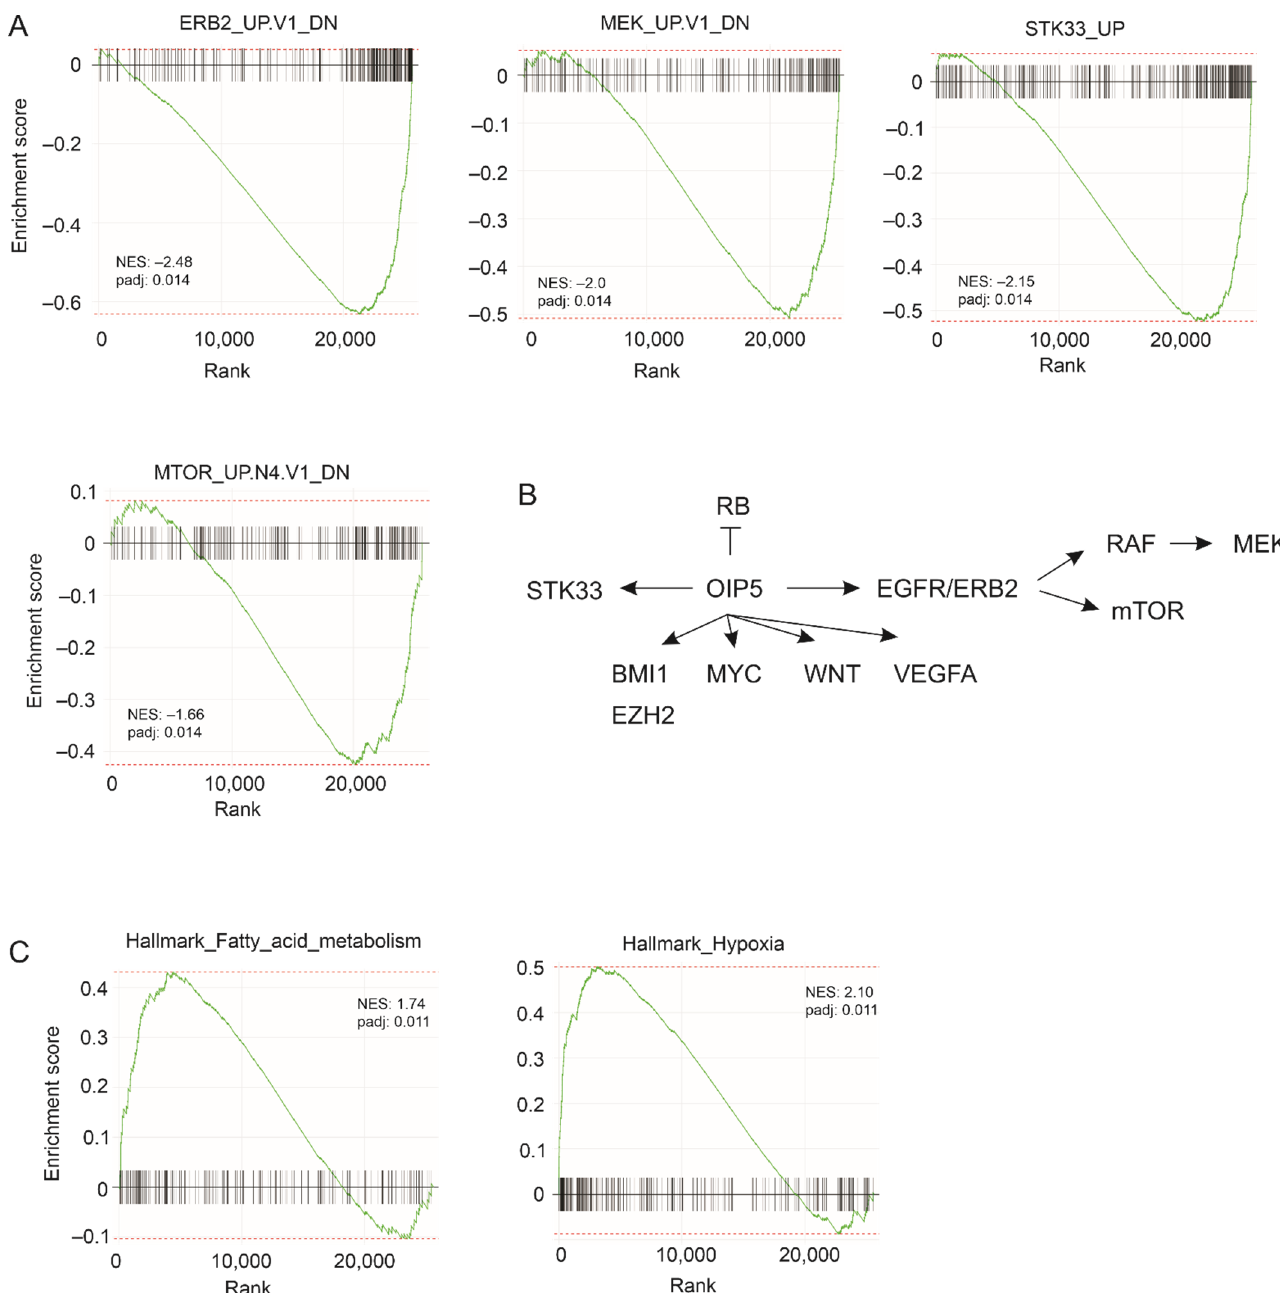
Figure 3. OIP5 induces network alterations during pRCC tumorigenesis. ( A ) GSEA (gene set enrichment analysis) on differentially expressed genes derived from the comparison of ACHN OIP5 tumors to ACHN EV tumors was performed with FGSEA within the Galaxy platform. The MSigDB oncogenic gene sets (C6) collection was used. ( B ) Summary of the major oncogenic gene sets affected in ACHN OIP5 tumors (see Table S1 for individual gene sets affected). ( C ) Enrichment of the indicated gene set within the MSigDB hallmark gene sets collection (see Table S2 for individual gene sets affected).